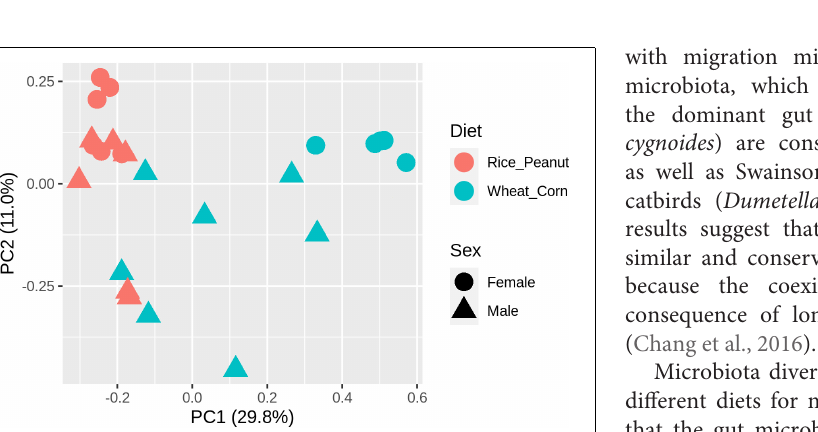
FIGURE 3 | Difference of alpha diversity between groups. (A) Shannon diversity indexes calculated for sexes with different diets, and (B) Pielou’s evenness for sexes with different diets. Significant difference with asterisks and lines were given, * means p < 0.05. The error bar (SE) was shown.